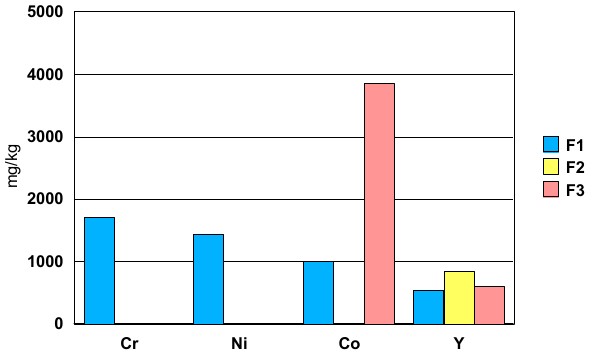
/ kg] found in solution.